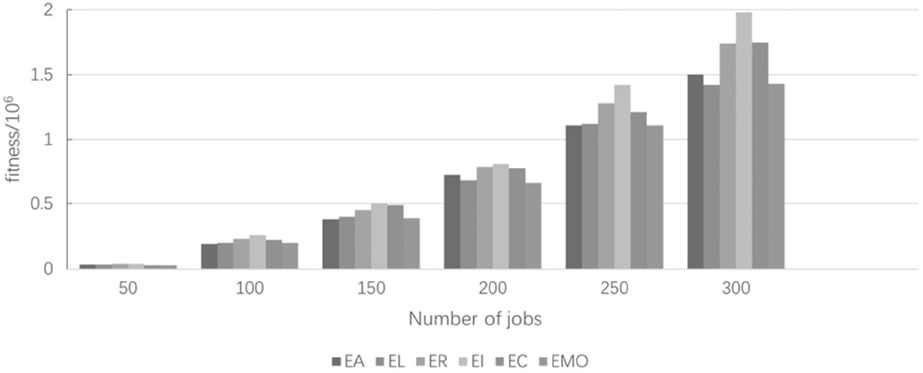
Figure 6. Fitness Figure 6. Fitness values.